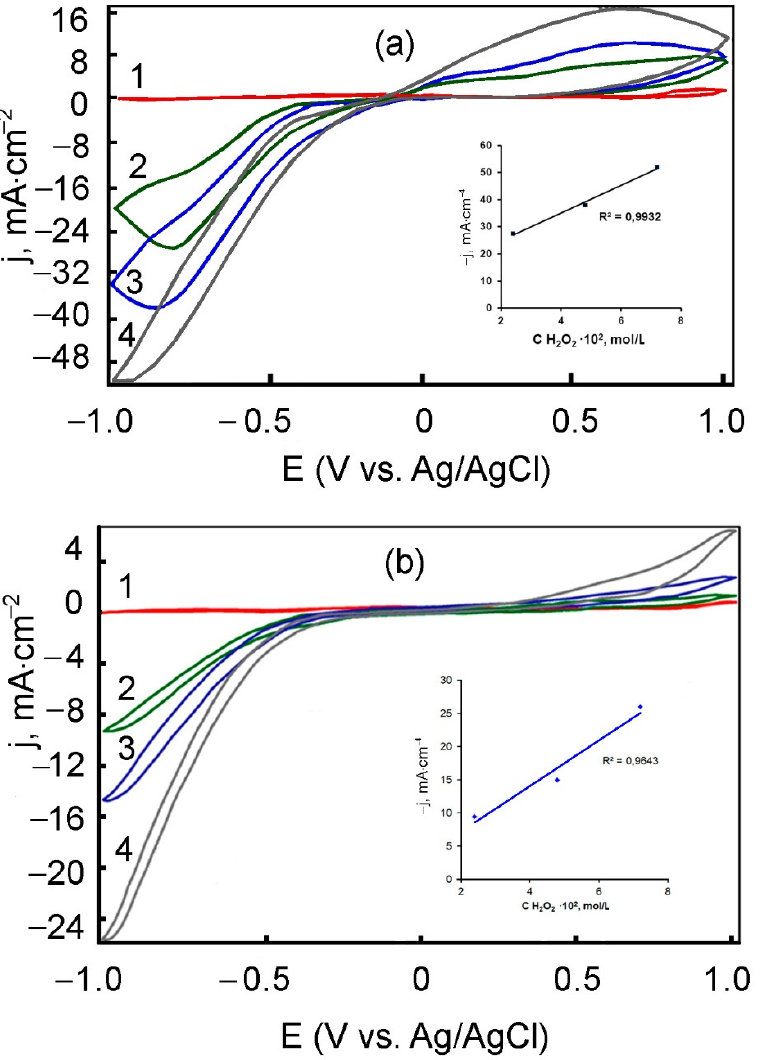
Figure 14. Cyclic voltammograms and dependence of the current density of the hydrogen peroxide reduction peak on its concentration for electrodes with PMAA/AuNPs (electrolyte 3) ( a ) and PMAA/AuNPs (electrolyte 4) ( b ) films in H 2 O 2 /PBS. H 2 O 2 concentration (mol/L): 0 (1), 2.4 × 10 − 2 (2), 4.8 × 10 − 2 (3), 7.2 × 10 − 2 (4). Scan rate 100 mV/s.